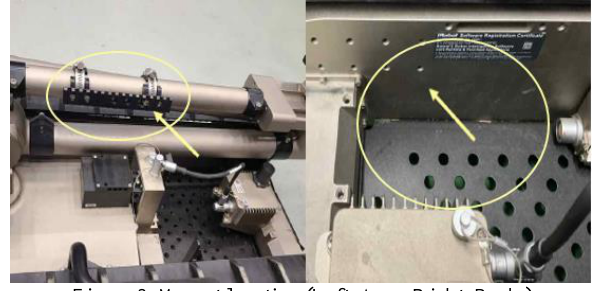
Figure 3. Mount location (Left: Arm, Right: Body) In addition, an integrated mount capable of combining the body and multiple sensor modules was designed and manufactured for the ease of scanning the sensor module while fixing it to the floor and side surfaces (Fig. 4).